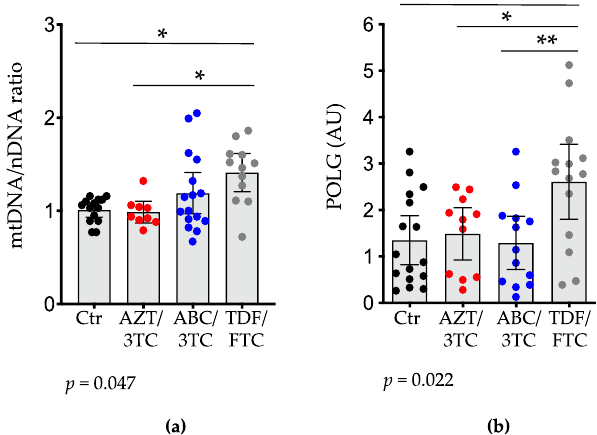
Figure 2. Placental mtDNA/nDNA ratio and mRNA levels of DNA polymerase gamma are elevated in pregnant mice treated with TDF/FTC. Mice were treated with either AZT/3TC (red dots), ABC/3TC (blue dots), TDF/FTC (grey dots), or water (control; black dots) throughout pregnancy. Placentas were collected at gestational day 15. ( a ) Placental mtDNA/nDNA, using ND1 and 16S RNA as the mitochondrial genes and HK2 as the nuclear gene. The average of the ratios of ND1/HK2 and 16S/HK2 is shown. n = 14 fetuses from 4 litters for control; n = 9 placentas from 4 litters for AZT/3TC; n = 16 placentas from 4 litters for ABC/3TC; n = 12 from 4 litters for TDF/FTC. ( b ) Placental mRNA expression levels of DNA polymerase gamma (POLG), with hypoxanthine-guanine phosphoribosyltransferase (HPRT) as the housekeeping gene. N = 16 placentas from 6 litters for control; n = 11 placentas from 6 litters for AZT/3TC; n = 13 placentas from 5 litters for ABC/3TC; n = 14 placentas from 6 litters for TDF/FTC. For both ( a , b ), data are scatter dot plots with mean and 95% confidence interval. Statistical comparisons by mixed-effects modelling to control for litter effects (using treatment as a fixed effect and litter as a random effect). * = p < 0.05, ** = p < 0.01. The p -values below the panels are for the model. AZT, zidovudine; 3TC, lamivudine; ABC, abacavir; FTC, emtricitabine; TDF, tenofovir; POLG, DNA polymerase gamma; AU, arbitrary units.